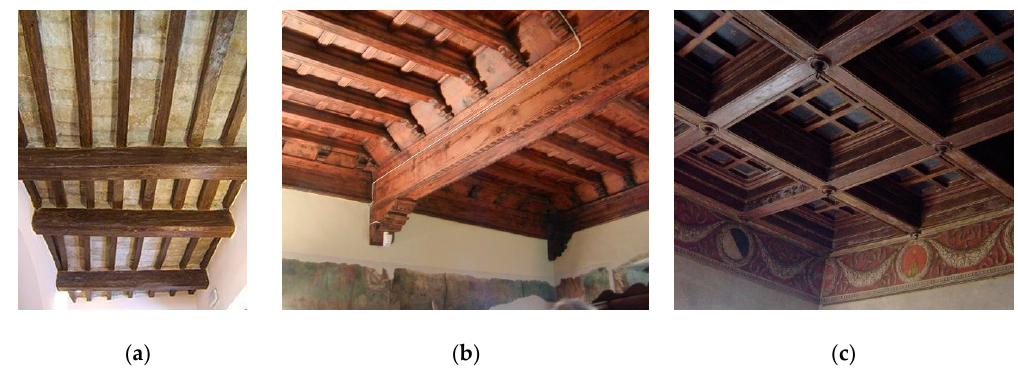
Figure 3. Historic joist floor.